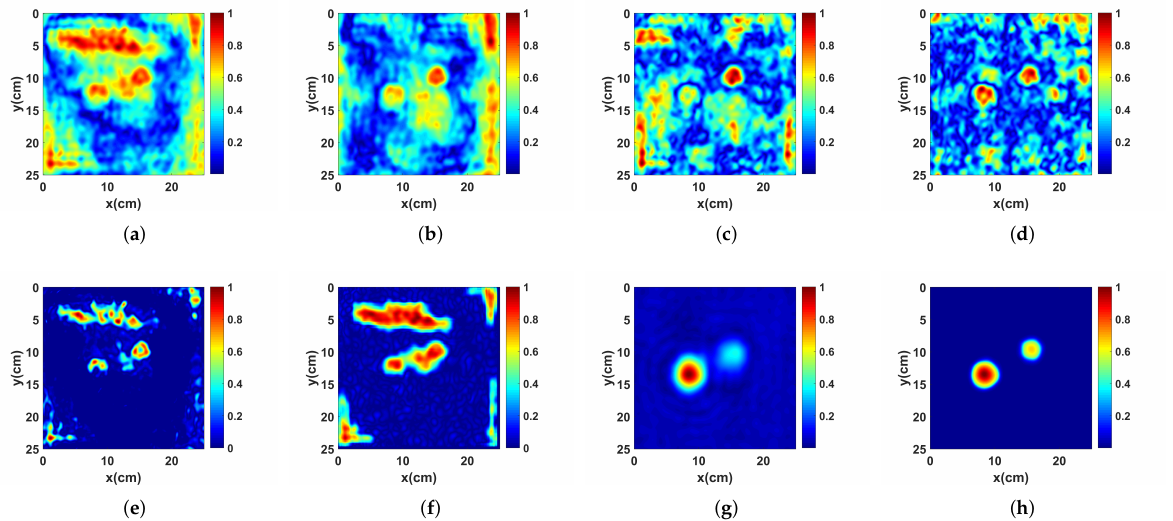
Figure 11. HSR images of Scene III before and after using different clutter mitigation methods. ( a ) No clutter mitigation. ( b ) Result of PCA. ( c ) Result of the standard SVD. ( d ) Result of the adaptive SVD. ( e ) Result of RPCA. ( f ) Result of MCA. ( g ) Result of the standard autoencoder. ( h ) Result of the proposed method.